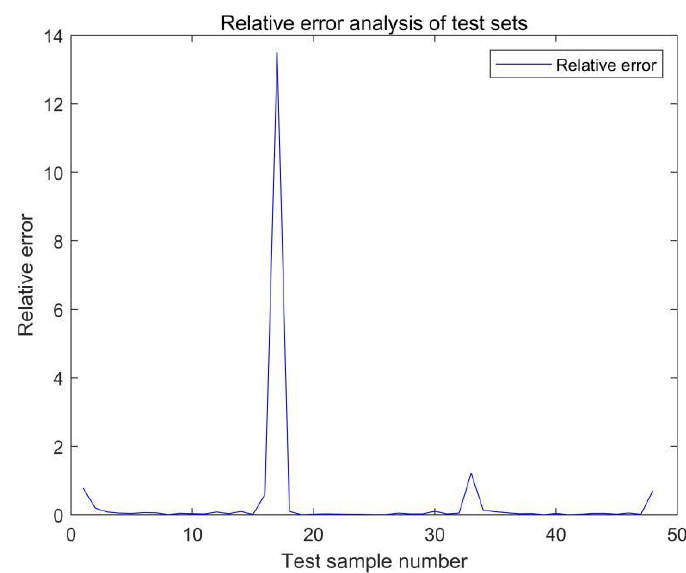
Figure 36. The relative error graph of the test set.